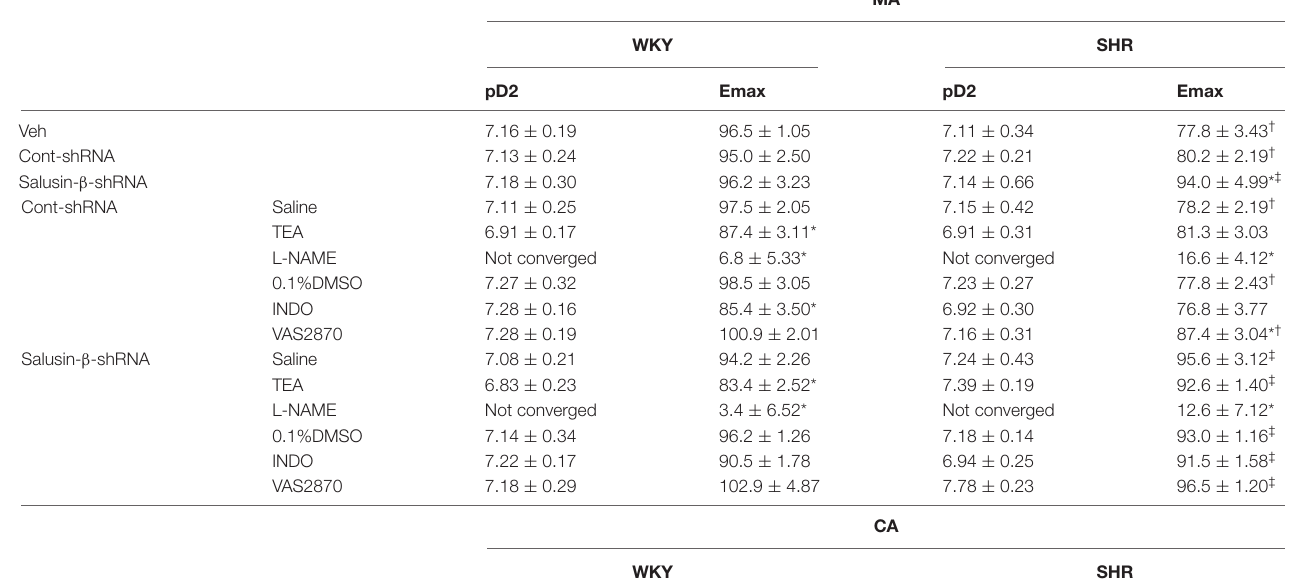
TABLE 3 | The Emax (%) and pD2 (-logEC50) data of ACh-induced dose-dependent vascular relaxation for each group of treatments on MA, CA, and PA in WKY and SHR.